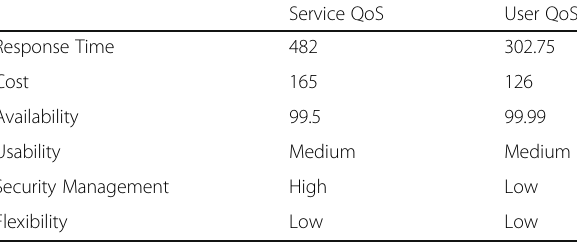
Table 4 Difference in Service and User